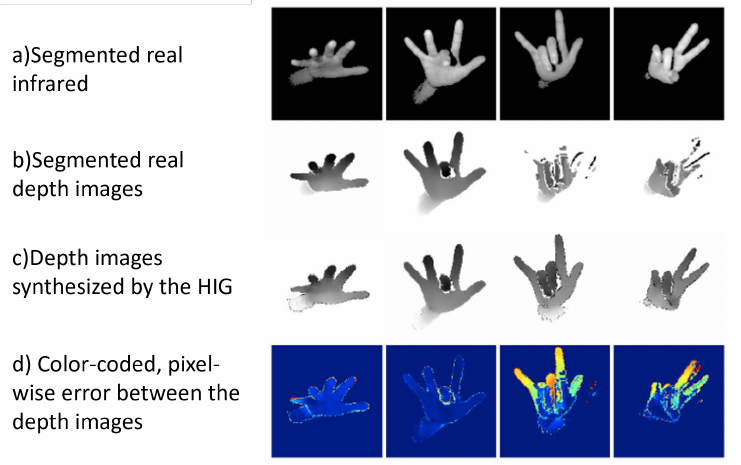
Figure 6. The HIG synthesizes a depth map from an infrared map. In the case of slow motion (the first and second column), the largest discrepancy is shown near the outline of the hand due to sensor noise. In the case of fast motion (the third and fourth column), the largest discrepancy is shown in blurry fingers. Originally reported in